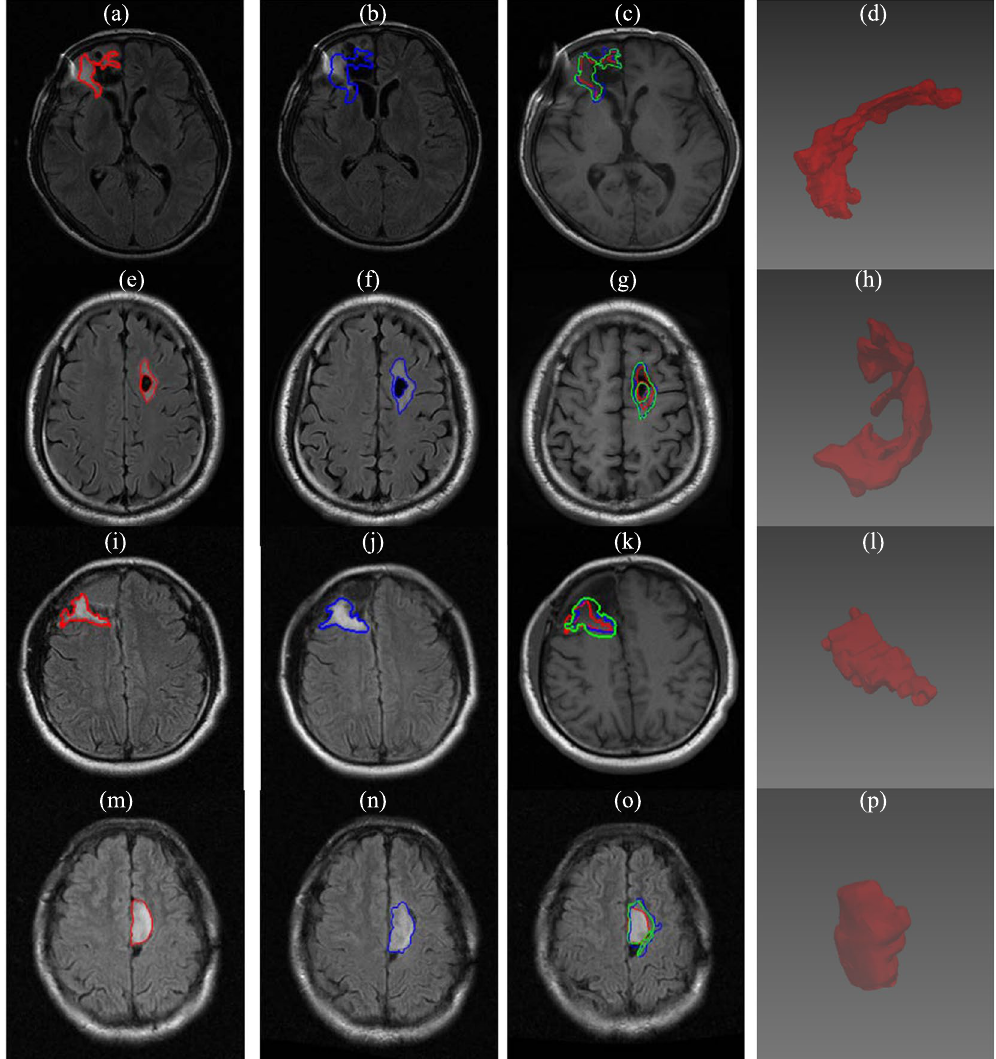
Figure 7. Simulation results of tumor growth from 4 LGG patients who underwent surgery without further treatment. The red ( a , e , i , m ) and blue ( b , f , j , n ) contours represent the ground truths of tumor boundaries on2 serial T2 MR images while the green contours ( c , g , k , o ) are the simulated growths on T1 MR images. ( d ), ( h ), ( l ), and ( p ) are constructed 3D views of the simulated tumor